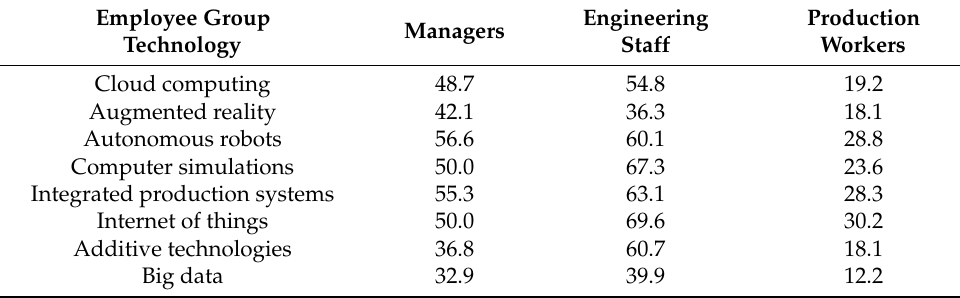
Table 3. Knowledge of various aspects of Industry 4.0 vs. job